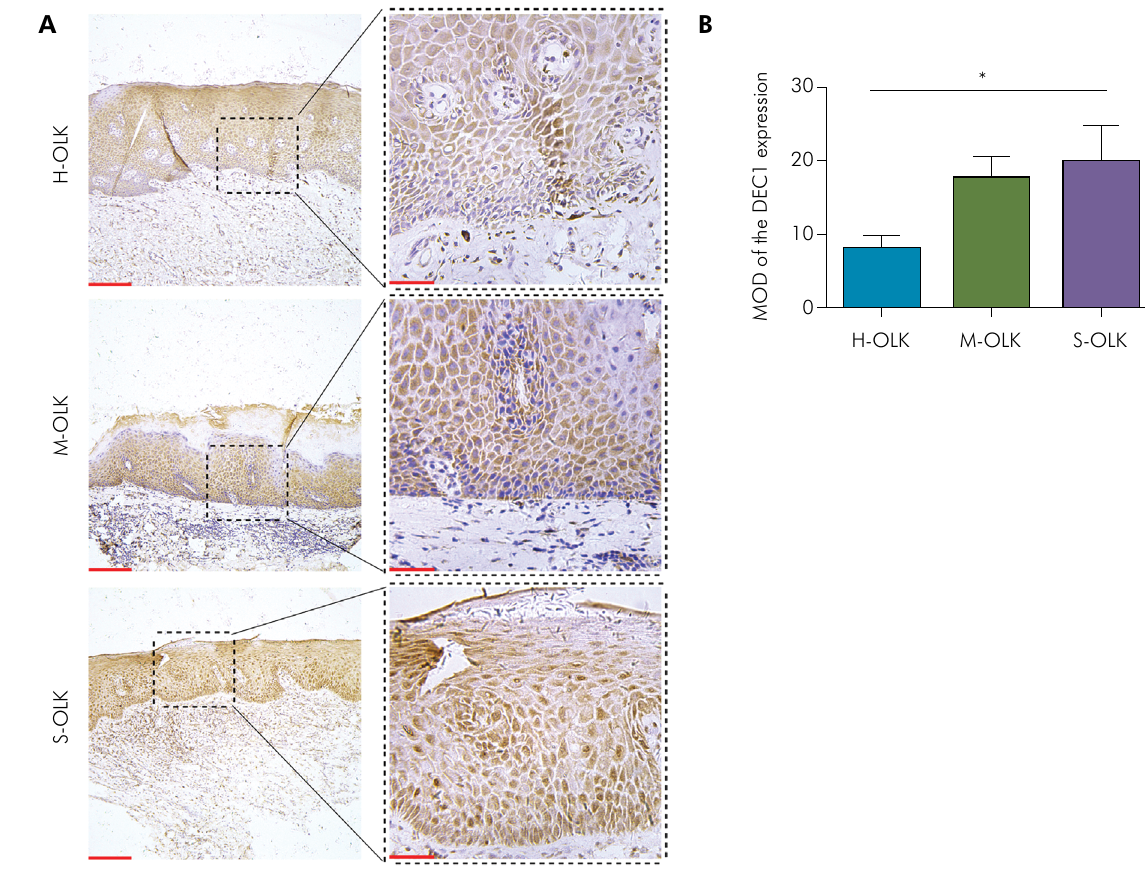
Figure 2. The connection between te expression of DEC1 and the degree of epithelial dysplasia with oral leukoplakia (OLK): (A) Immunohistochemical staining for DEC1 in the OLK group. Scale bar (left side) = 100 μm, scale bar (right side) = 25 μm. (B) In the OLK group, the expression of DEC1 in the mild dysplasia subgroup (M-OLK) was higher than that in the hyperkeratosis without dysplasia subgroup (H-OLK) and lower than that in the moderate to severe dysplasia subgroup (S-OLK). The difference between H-OLK and S-OLK was statistically significant. *indicates p < 0.05, the bar on the column refers to SEM: Structural Equation